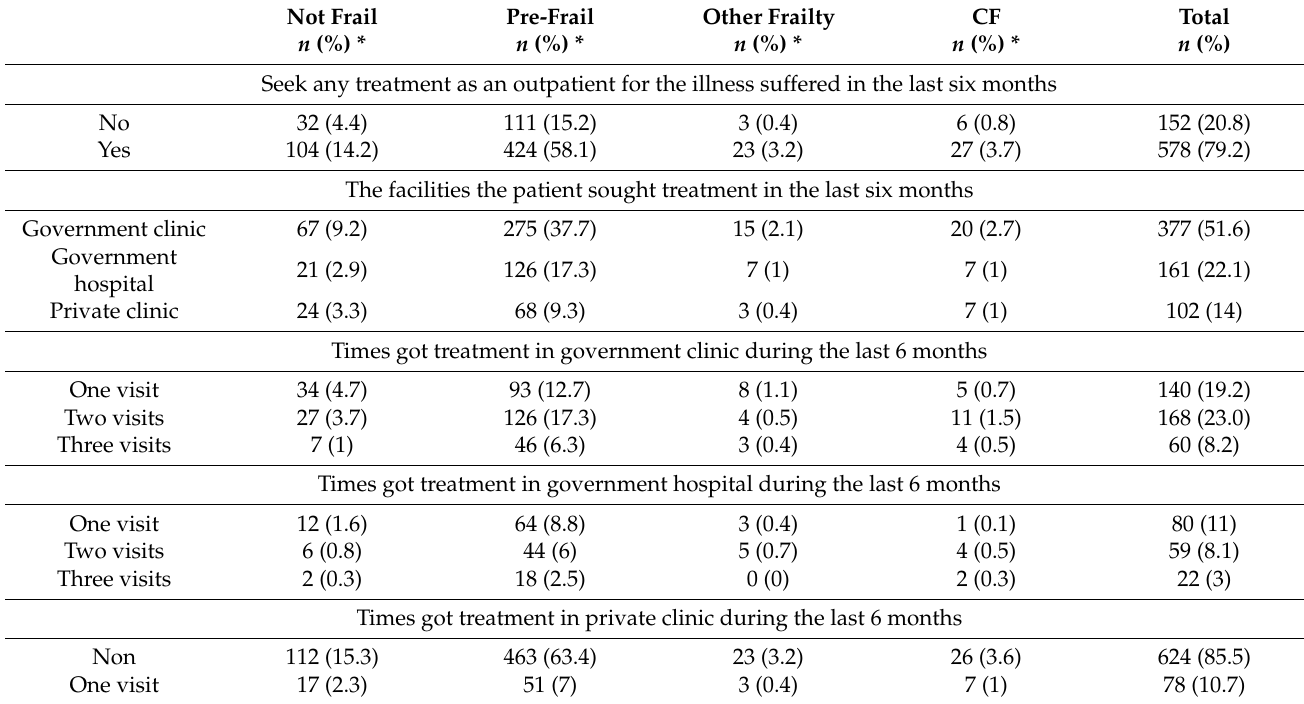
Table 3. Outpatient health care utilization findings during the past six